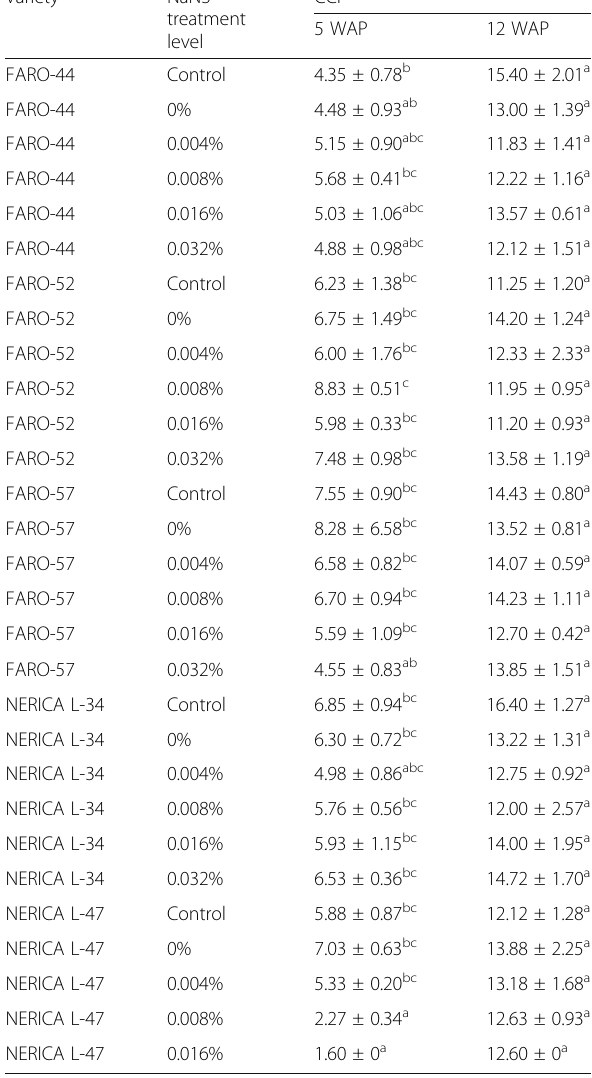
Table 4 Chlorophyll content index (CCI) of the five rice varieties at 5 WAP and 12 WAP